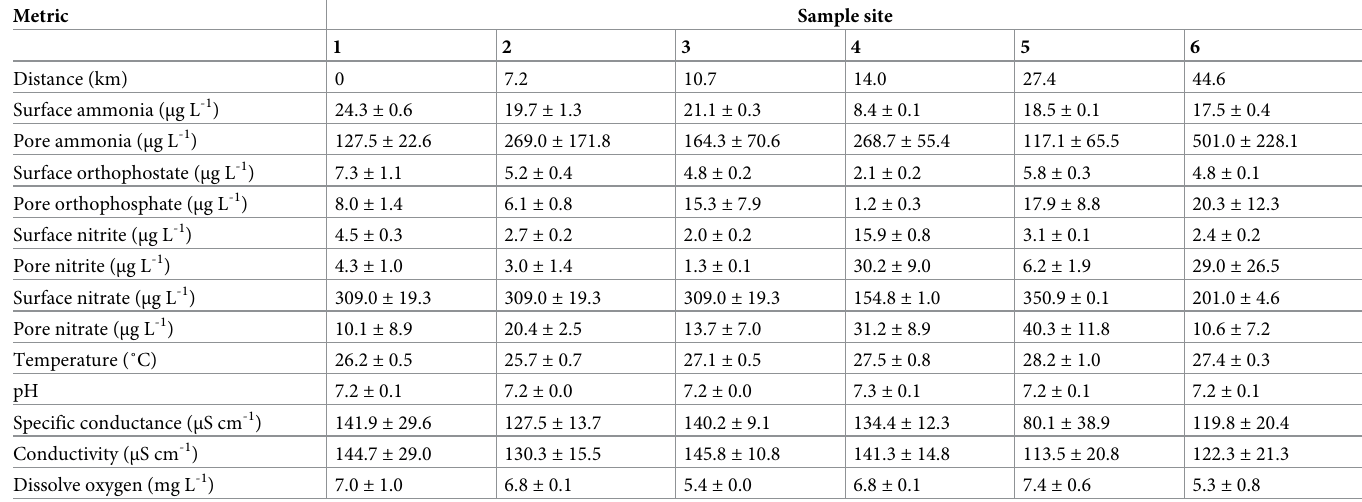
Table 2. Physicochemical data from six sites along the Sipsey River, AL, USA. “Surface” measurements reflect readings from the water column and “pore” reflects pore- water readings. Sites are ordered moving downstream and the distance from the first site is noted. Three measurements of each environmental parameter were recorded between June 9 and September 28, 2016. Data shown reflects the means of these three measurements and the standard